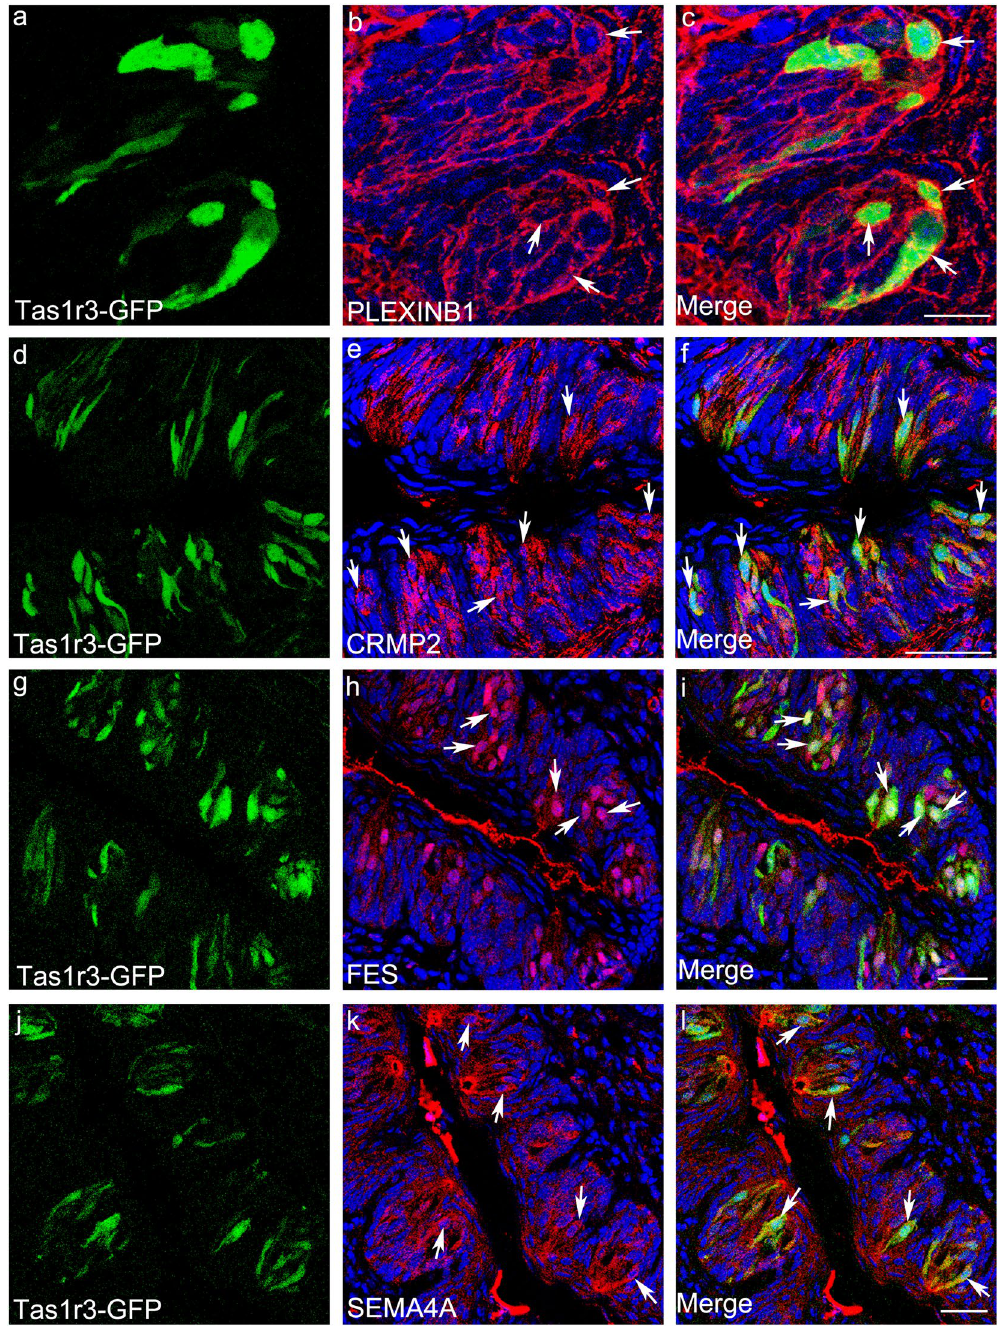
Figure 6. Expression of semaphorin pathway genes in Tas1r3 + taste cells. Immunostaining identifies the semaphorin pathway components PLEXINB1, CRMP2, FES and SEMA4A (red, a,d,g,j ). Intrinsic fluorescence of Tas1r3-GFP identifies Tas1r3 + taste cells (green, b,e,h,k ). Merged images ( c,f,i,l ) indicate that most Tas1r3 + cells express the semaphorin pathway components examined, and that they are expressed in other taste cells also. Arrows point to cells co-expressing Tas1r3-GFP and PLEXINB1, CRMP2, FES or SEMA4A. Scale bars: c = 16 µ m, f, i, l = 40 µ